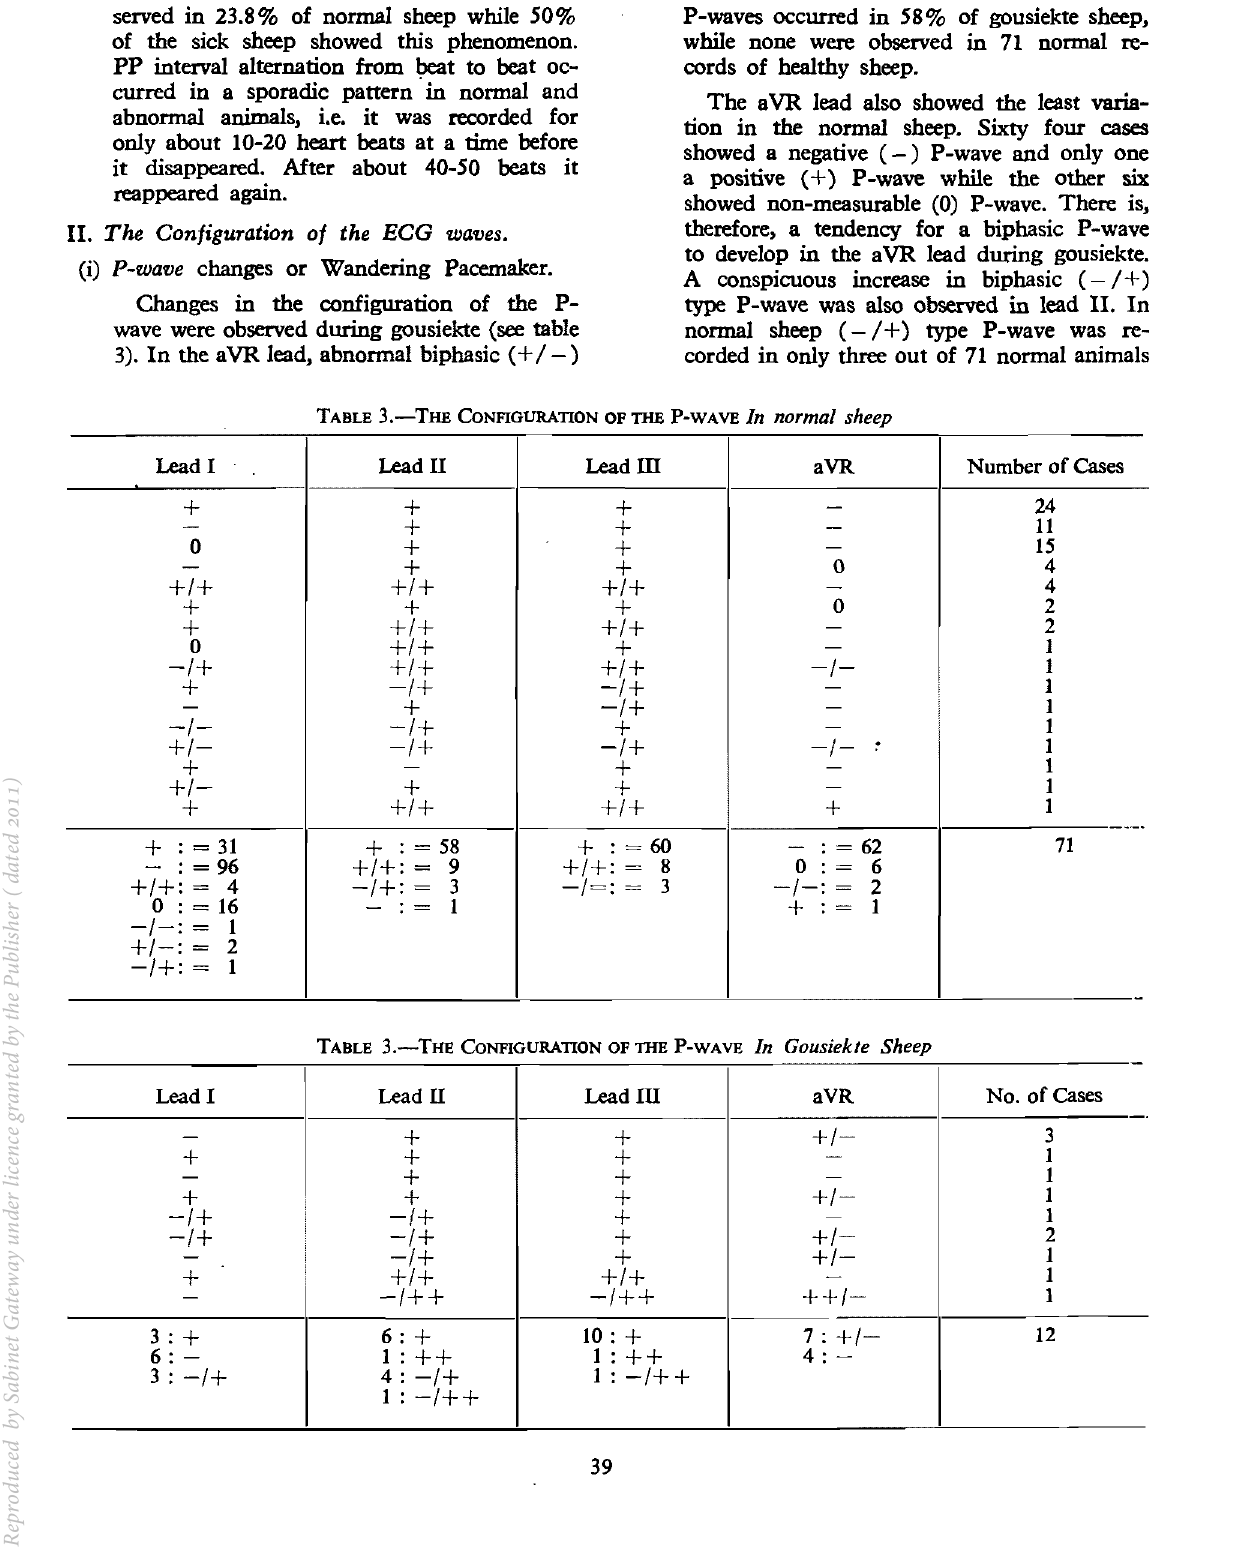
TABLE 3.-THE CONFIGURATION OF THE P-WAVE In Gousiekte